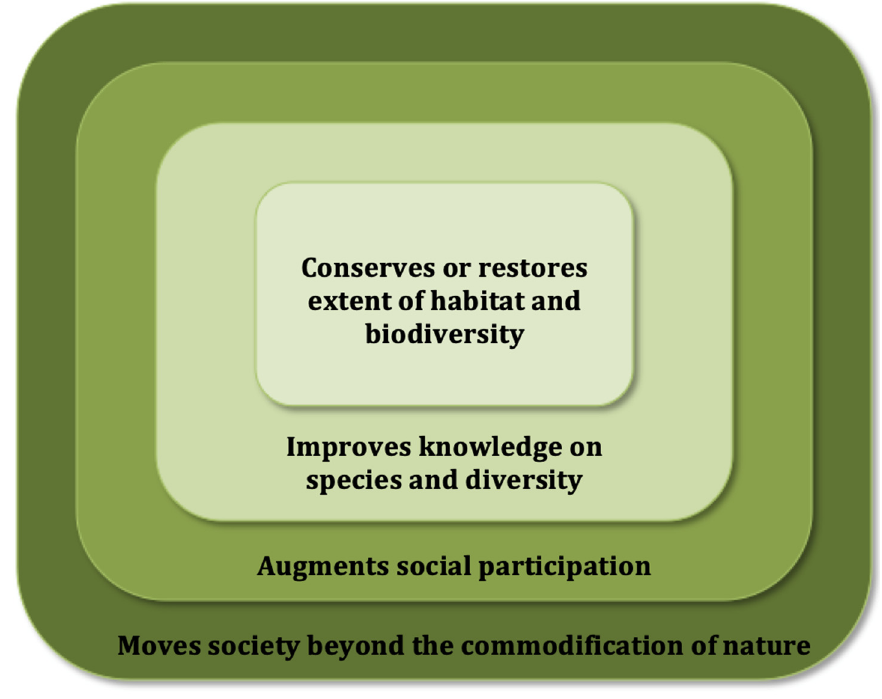
Figure 1. Four levels of ambition on bioeconomy promotion that secure and enhance NCPs